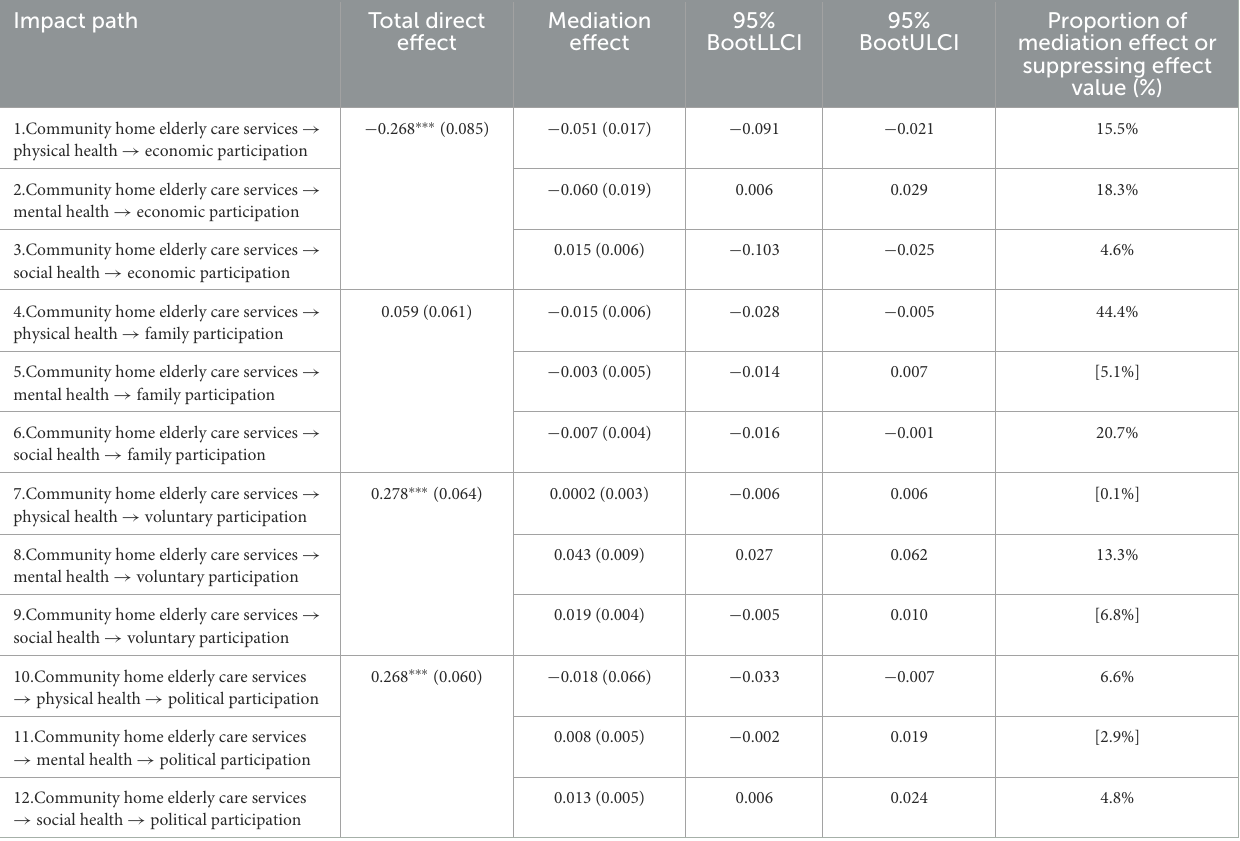
TABLE 5 Multiple health mediating